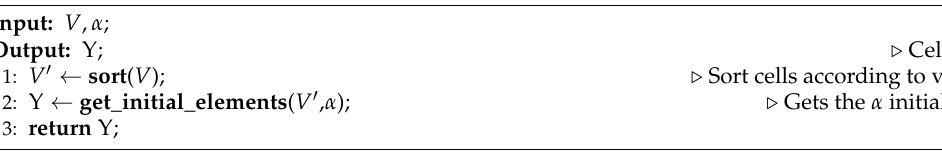
Algorithm 2 Strategy dl : Covering the most popular cells